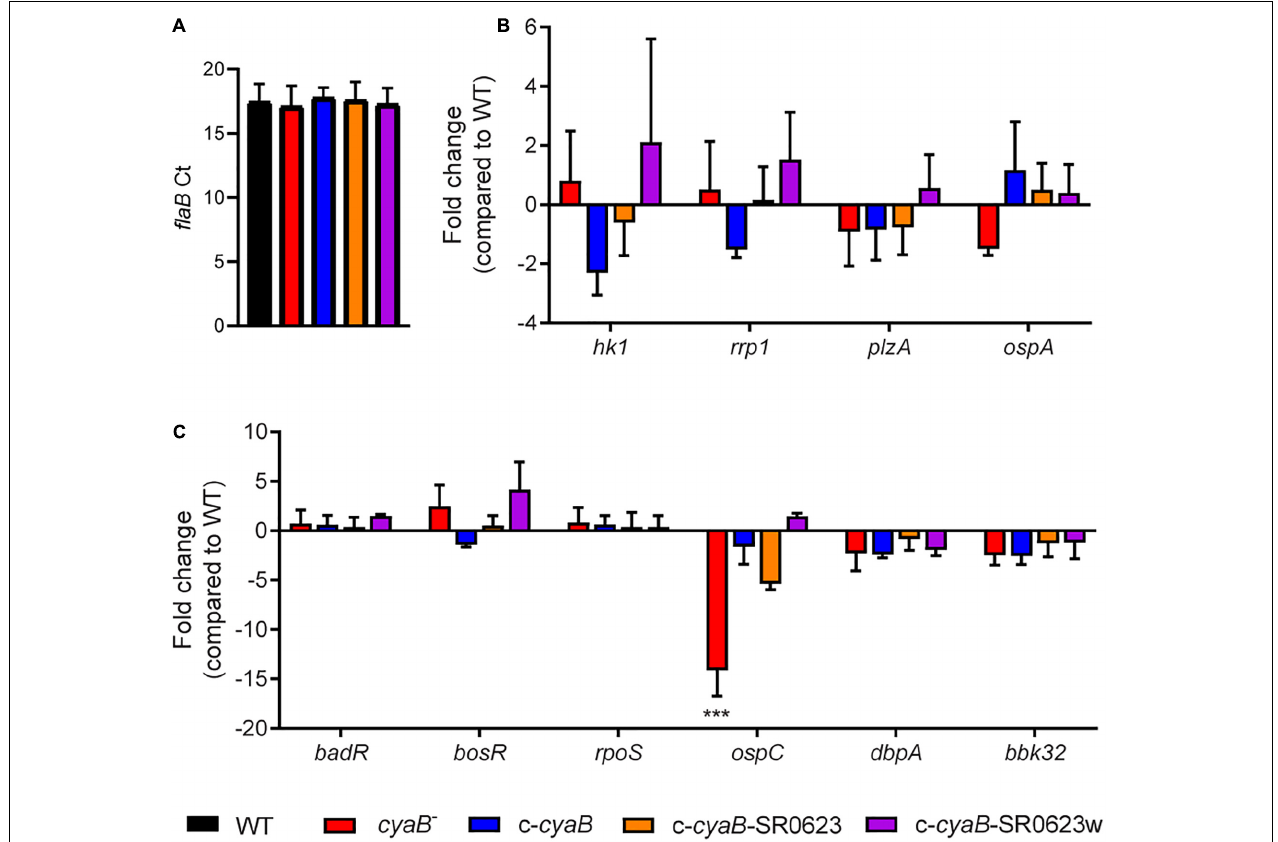
FIGURE 4 | Deletion of cyaB reduces ospC expression. B. burgdorferi was grown in BSK-glycerol to mid-logarithmic phase at 32 ◦ C 1% CO 2 for qRT-PCR analysis. (A) Comparison of the Ct values for the endogenous reference gene flaB . Relative transcript levels of virulence determinants for the (B) tick and (C) mammalian cycle. Fold changes are compared to WT. Shown are the averages and standard error of three biological replicates. Statistical analysis was performed using one-way ANOVA with Dunnett correction relative to WT, *** p <